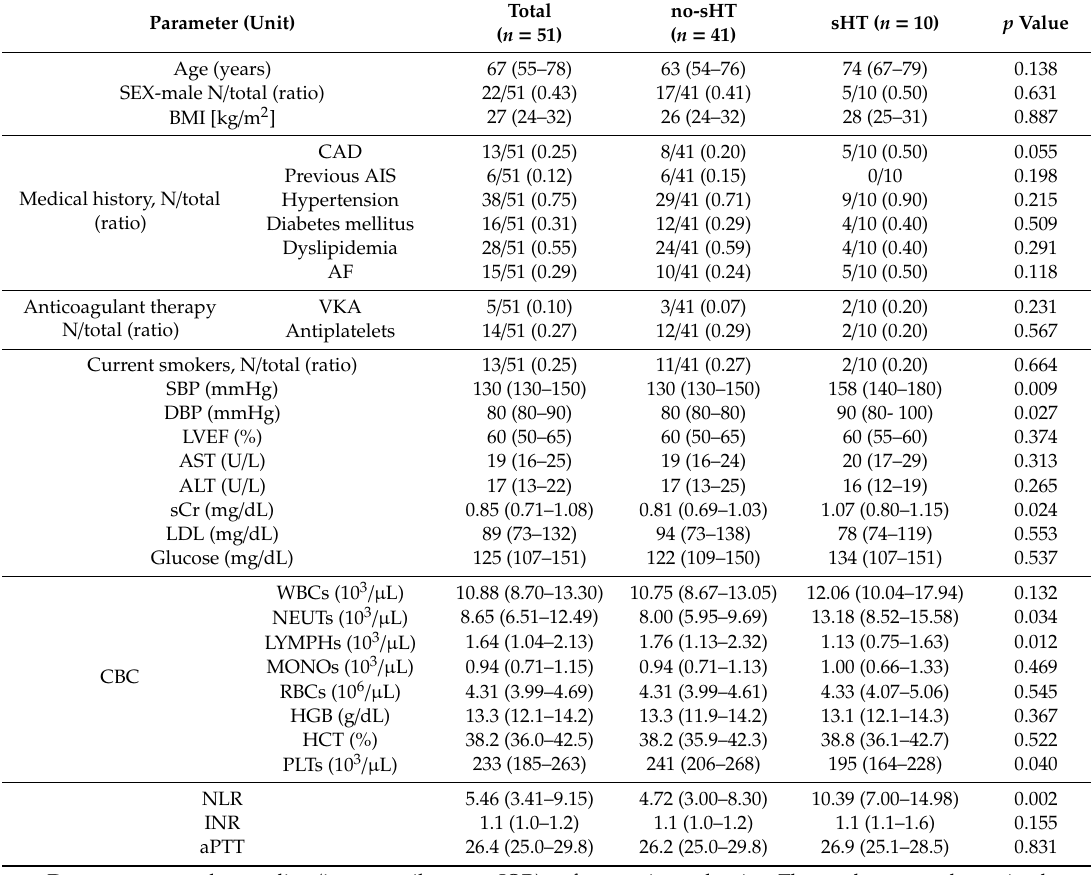
Table 1. Baseline characteristics of patients according to Symptomatic hemorrhagic transformation (sHT). Parameter